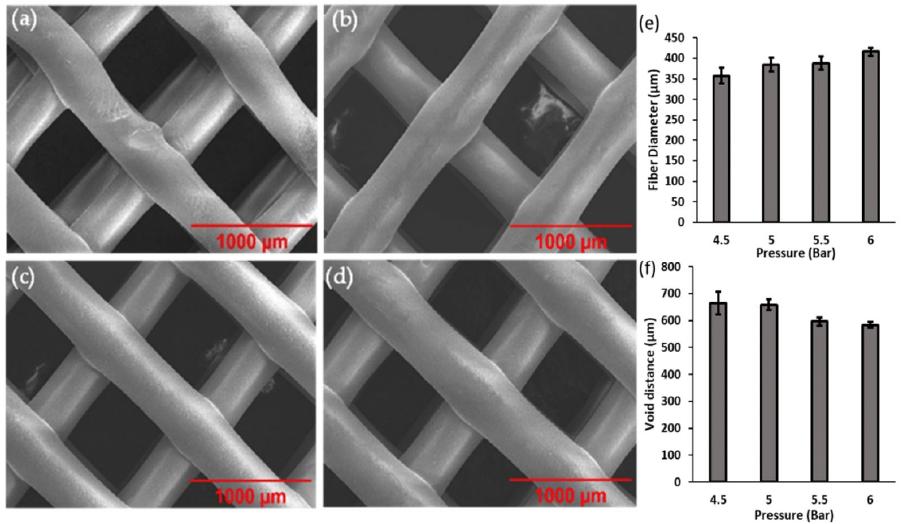
Figure 2. SEM images of 3D ‐ printed PCL at ( a ) 4.5 bar, ( b ) 5.0 bar, ( c ) 5.5 bar and ( d ) 6.0 bar. Distribution of average measurement for ( e ) fiber diameter and ( f ) void distance at various pressures.